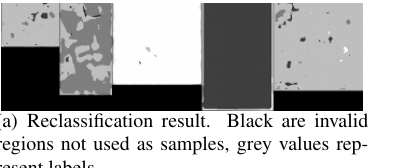
Figure 3: Intermediate results of the refinement process shown in Figure 2. Reclassification result (a) and uncertainty (b) are used to refine the label image resulting in (c).